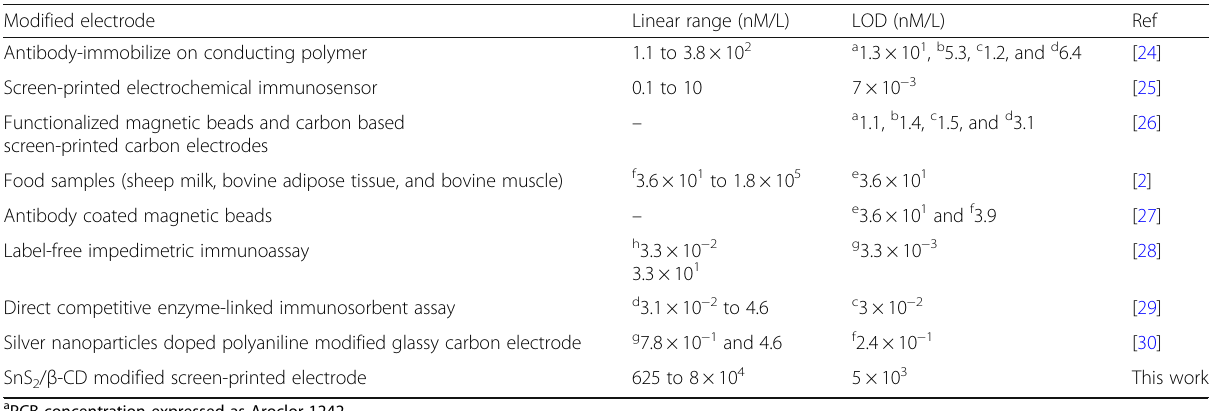
Table 1 The electrochemical performance of PCBs based on SnS 2 / β -CD/SPCE compared with previous reports Modified